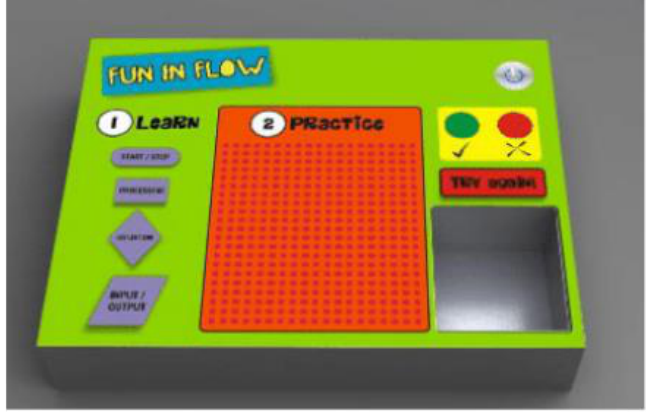
Figure 5. Overall structure of a TUI for learning flow charts and algorithms [16].